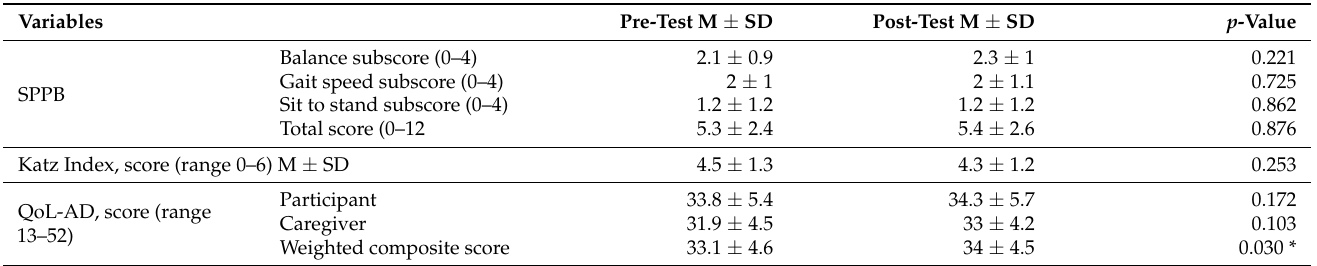
Table 4. Variables of physical abilities, functional capacities and quality of life before and after a 3-month tango program.